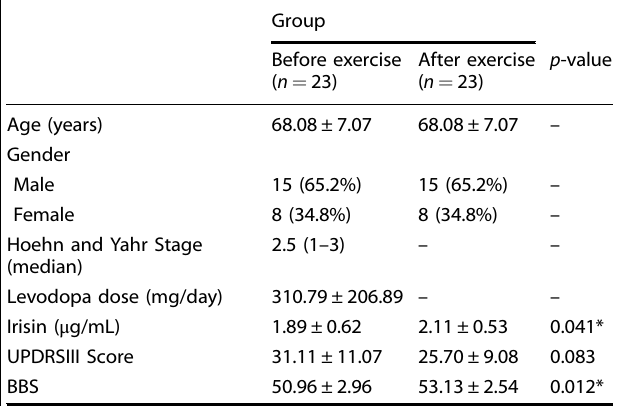
Table 1. Demographic data, motor function score, and laboratory results of patients with Parkinson ’ s